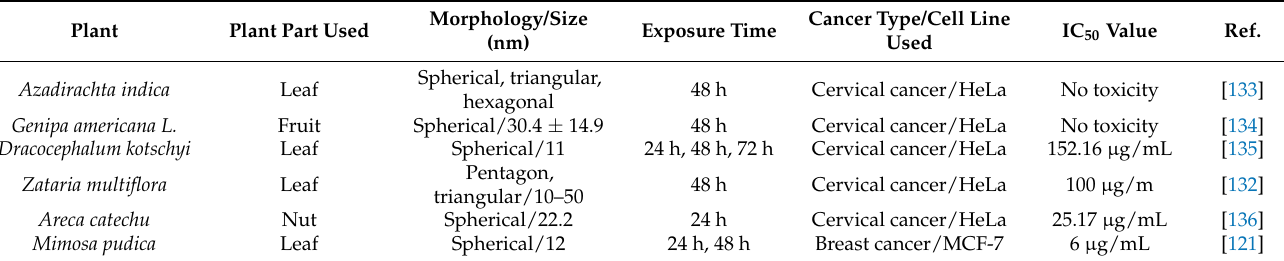
Table 2. List of studies exhibiting biosynthesized gold NPs and their anticancer activity.